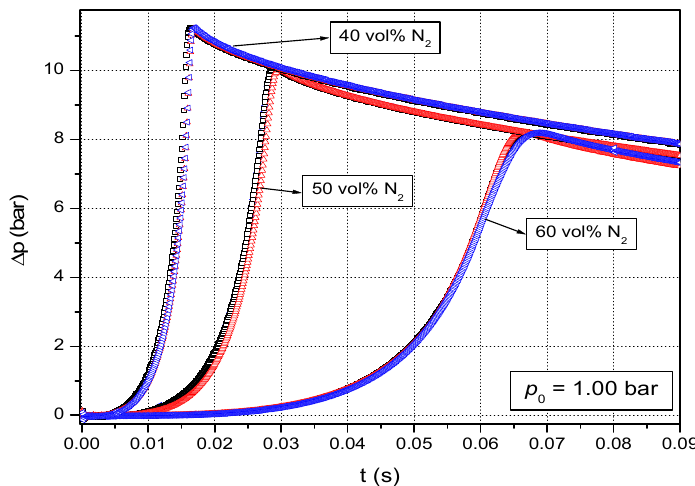
Figure 1. Experimental pressure-time history of the combustion process. Methane (99.99%), N 2 O and N 2 (both 99.999%) were provided by SIAD Italy and were used without any purification.